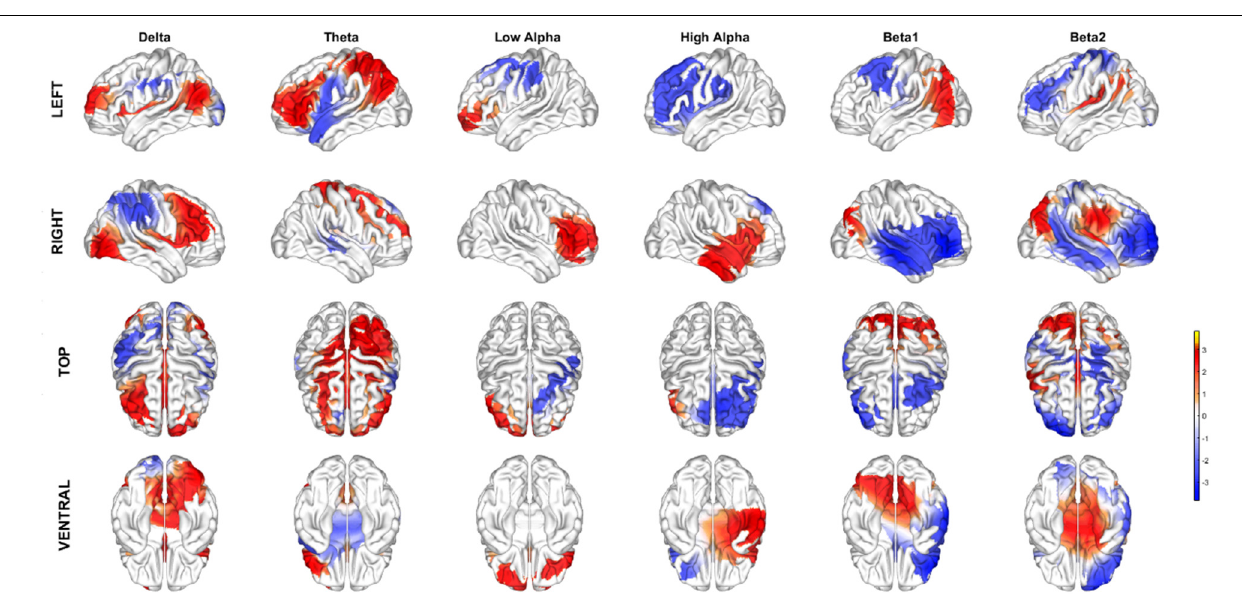
The highest loadings are for DRS, followed by FAB, while the minimum loading is for Memory within this narrow